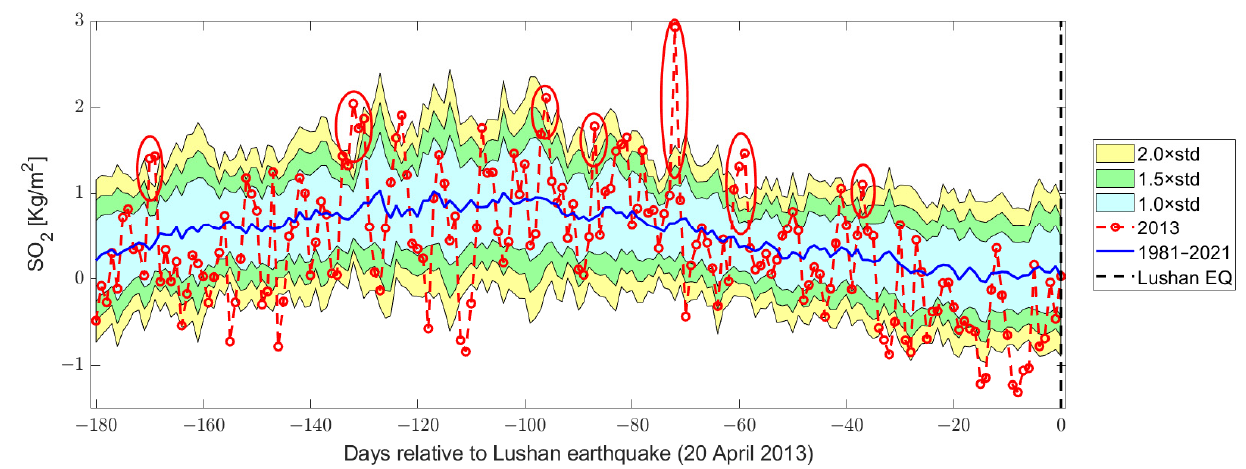
Figure 14. SO 2 levels from the six months before the Mw 6.7 Lushan 2013 earthquake. In Figure 15, a map for each atmospheric parameter on an anomalous day is reported. In particular, CO levels showed two anomalous days: 10 and 11 December, and both are reported. It is possible to see that on the first day, the highest pixels were located on the main plate boundary and closer to the future epicenter. In contrast, only the anomaly closest to the future epicenter persisted on the second day, suggesting a possible relation with the upcoming seismic event.